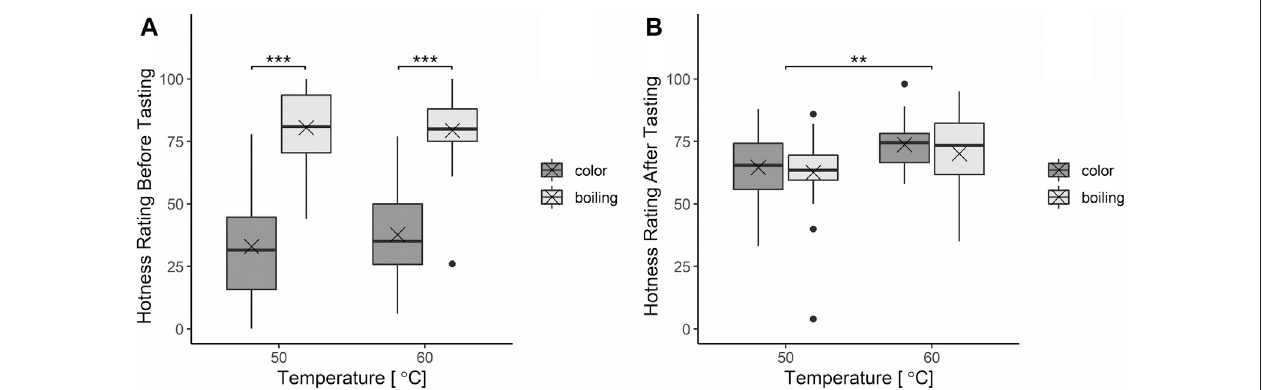
FIGURE 7 | (A) Ratings of the hotness of the curry before tasting and (B) after tasting.